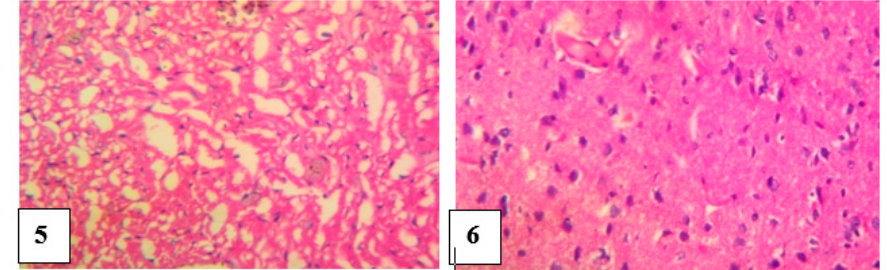
Figure 7. Histological examination of the heart of envenomed treated rats (×400) Group 1 (normal control): cardiomyocytes appeared normal, Group 2 (venom control): multiple foci of thinning and attrition of cardiomyocyte and epicardia hemorrhages, Group 3 (antivenom control): extensive foci of mild pallor of the cardiomyocytes, Group 4 (venom/200 mg/kg extract): focus of the cardiomyocytes, Group 5 (venom/400 mg/kg extract): few foci and mild pallor of the cardiomyocytes, Group 6 (venom/600 mg/kg extract):cardiomyocytes appeared normal.